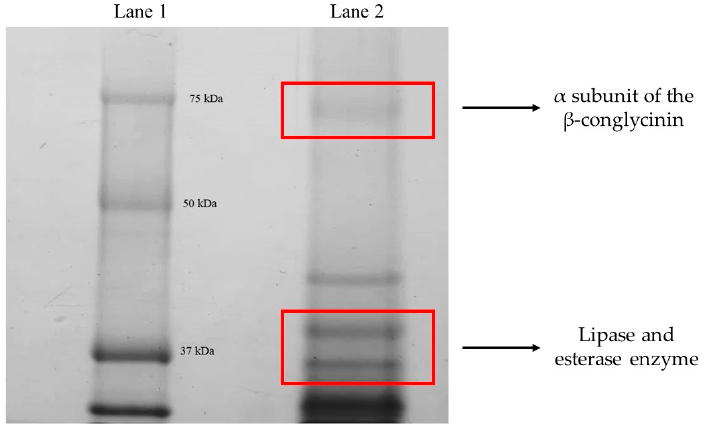
Figure 5. Electrophoresis analysis of the crude enzymatic extract (SDS-PAGE) from solid-state fermentation using andiroba oil cake and soybean meal (50:50) without supplementation. Lane 1: Standard protein markers. Lane 2: Andiroba oil cake and soybean meal (50:50) samples.